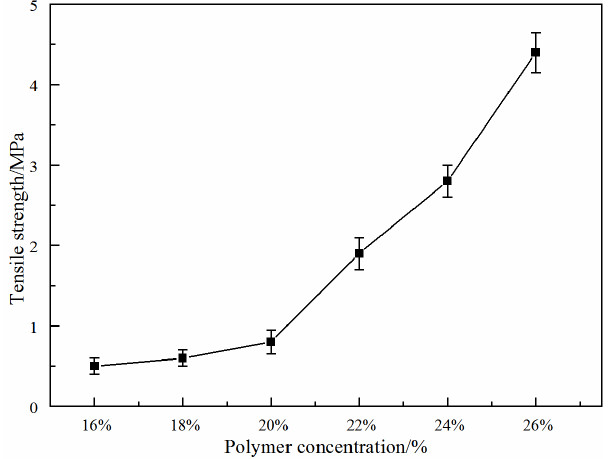
Figure 5. Effect of total polymer concentration on membrane tensile strength for PVDF/PVA blend membranes S 1 – S 6 .